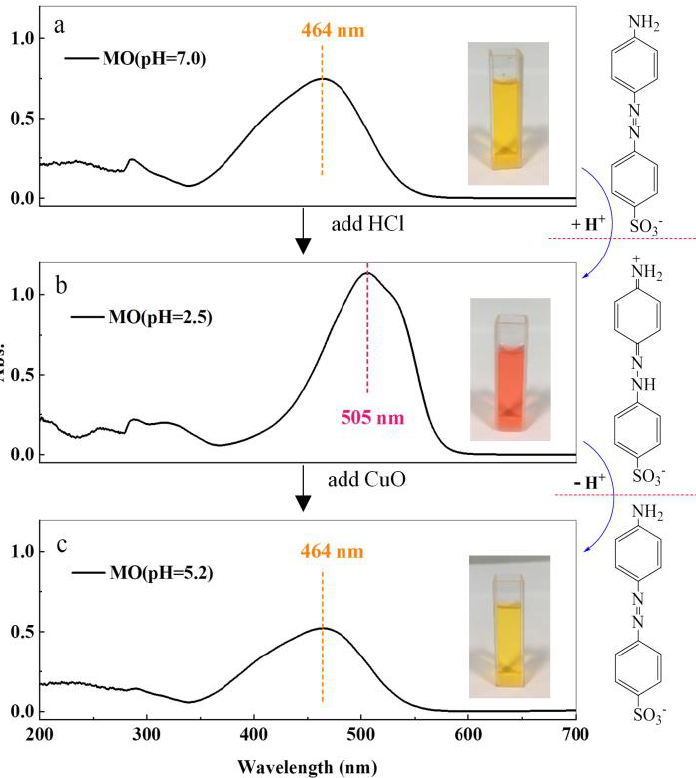
Figure 5. Changes of maximum adsorption peak and color in MO solution and evolution of MO molecular structure under H + ions. ( a ) MO solution with pH = 7.0. ( b ) MO solution with pH = 2.5. ( c ) The results of MO supernatant after H+ adsorption on CuO surface.